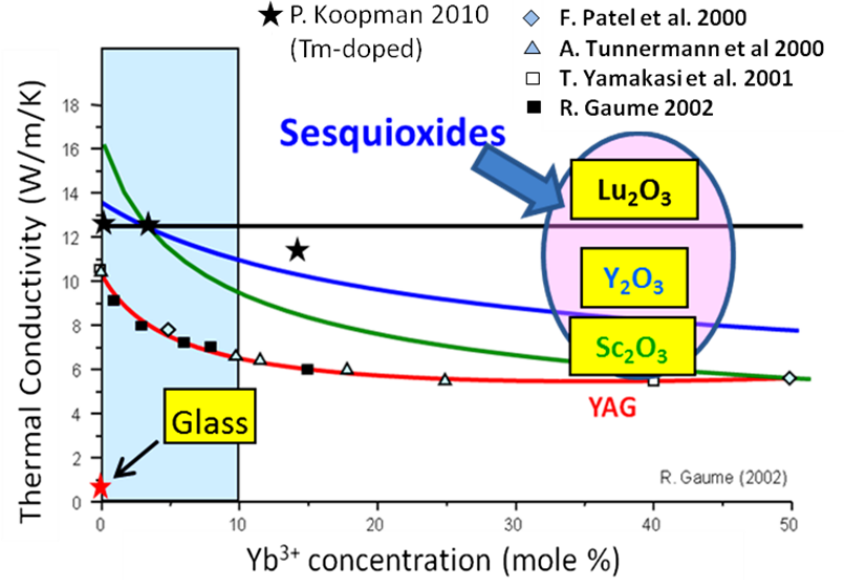
Figure 1. Thermal conductivity versus dopant concentration for crystals (Adapted from R. Gaume 2002 [4], P. Koopmann [6], F. Patel [7], A. Tunnermann [8] and T. Yamakasi